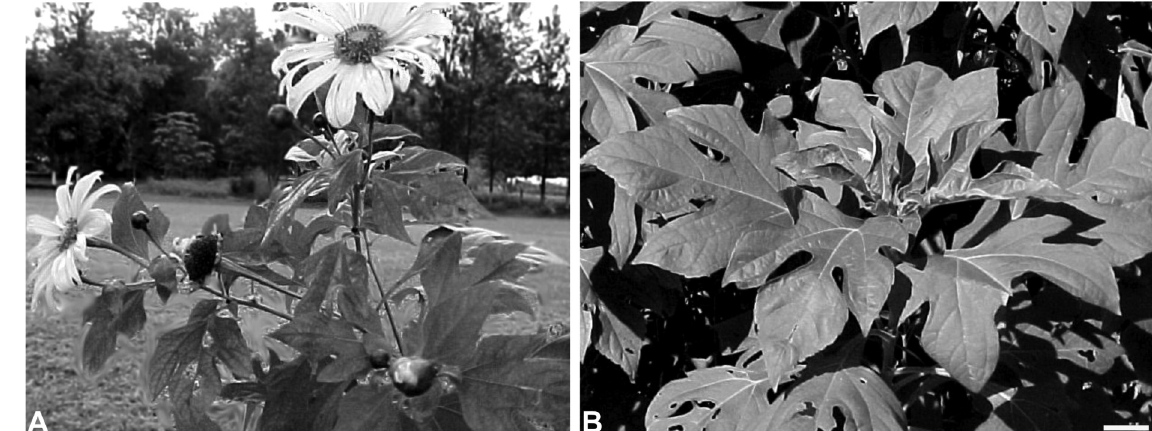
FIGURE 1 - A, B - Tithonia diversifolia (Hemsl.) A. Gray: A . Reproductive apical branches; B . Leaves. Bar = 2